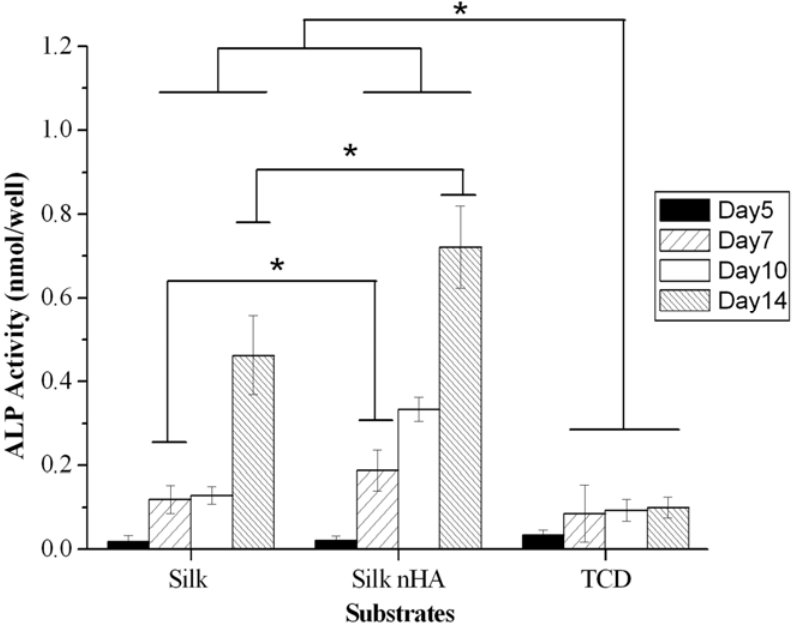
Figure 15. Alkaline phosphatase (ALP) activity on pure and mineralized silk/nHA nanofibers after 5, 7, 10 and 14 days of cell culture. Significant difference between different materials groups were denoted as * (p <